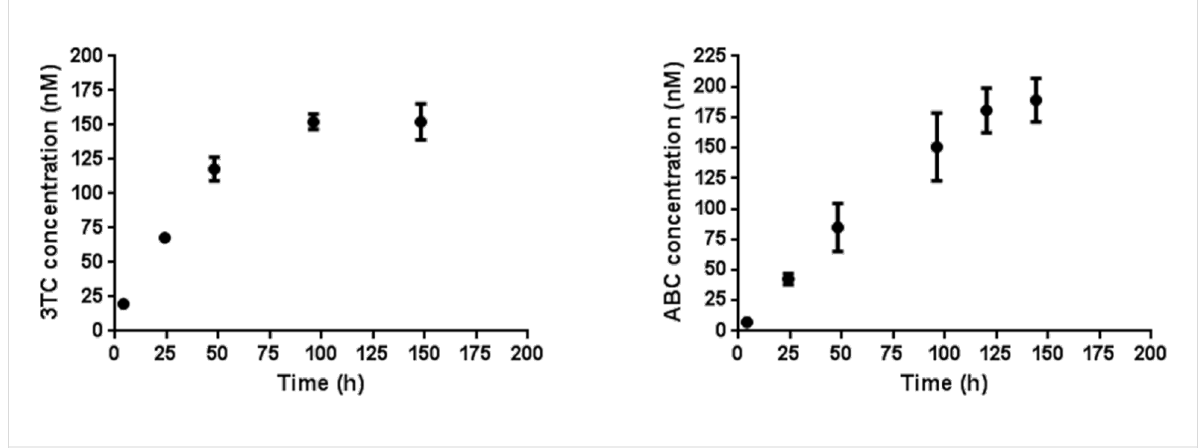
Figure 2: Time course release of free 3TC and ABC from the corresponding GNPs in 1 N HCl, detected by HPLC–MS measurements. Left: Release of 3TC from 2 µg/mL 3TC-GNPs for ~150 h. Right: release of ABC from 2 µg/mL ABC–GNPs for 170 h until a stable drug concentration in the release medium is reached. Both experiments were performed in